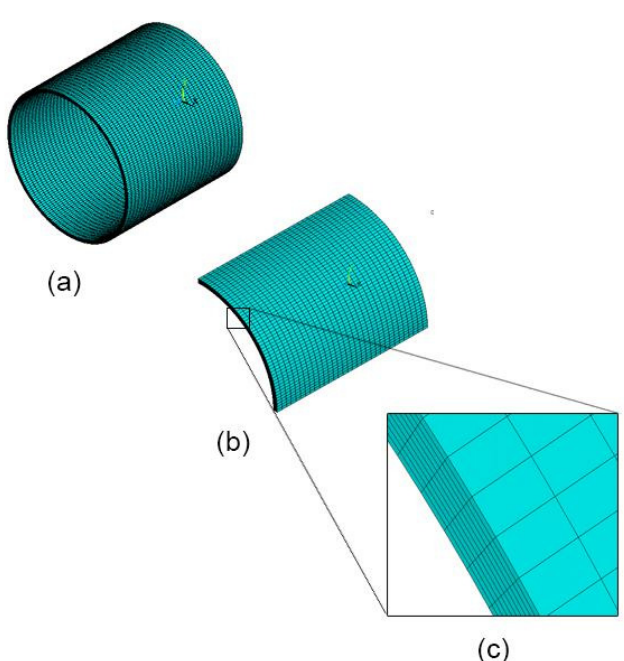
Figure 6. ( a ) Full FE model of the cylinder, ( b ) quarter axisymmetric model of meshed elements, and ( c ) magnified segment of the meshed elements showing the fine meshing in the radial direction.